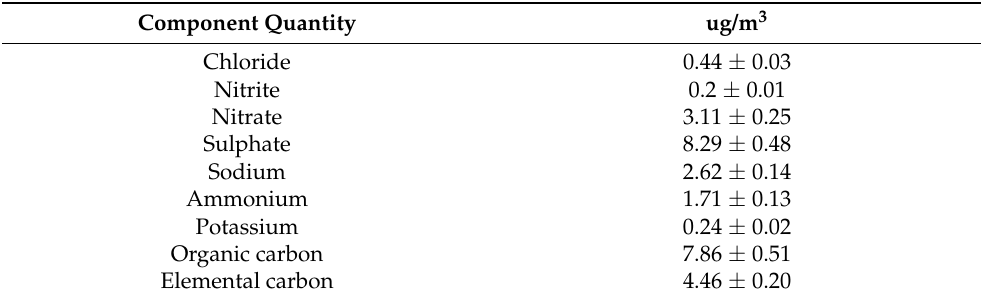
Table 1. Chemical characteristics of PM 2.5